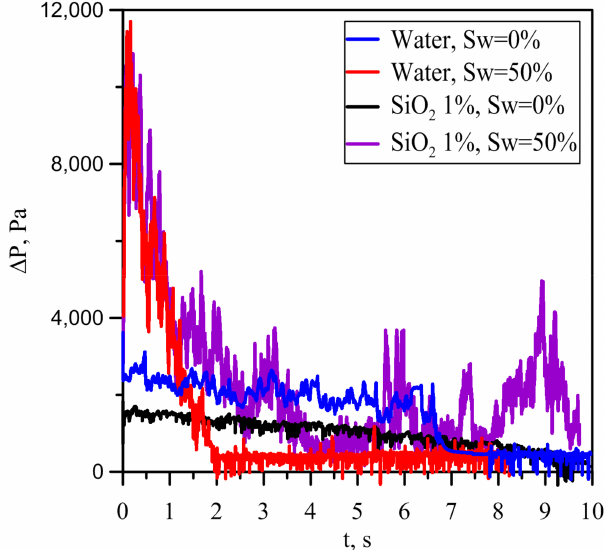
Figure 9. The pressure drop depending on time for water and nanosuspension with a weight concentration of 1% at water saturations of 0 and